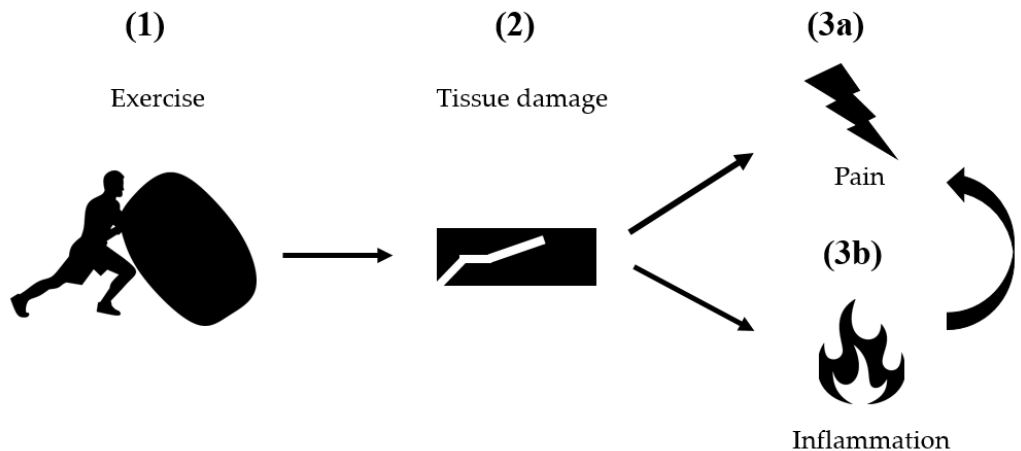
Figure 1. Schematic model of a fascial DOMS-origin. During strenuous exercise ( 1 ), morphological damage occurs in the extramuscular connective tissue ( 2 ), which stimulates algogenic free nerve endings ( 3a ). At the same time, local inflammation and edema produce local swelling and further increase pain ( 3b ). Original figure created by the authors.